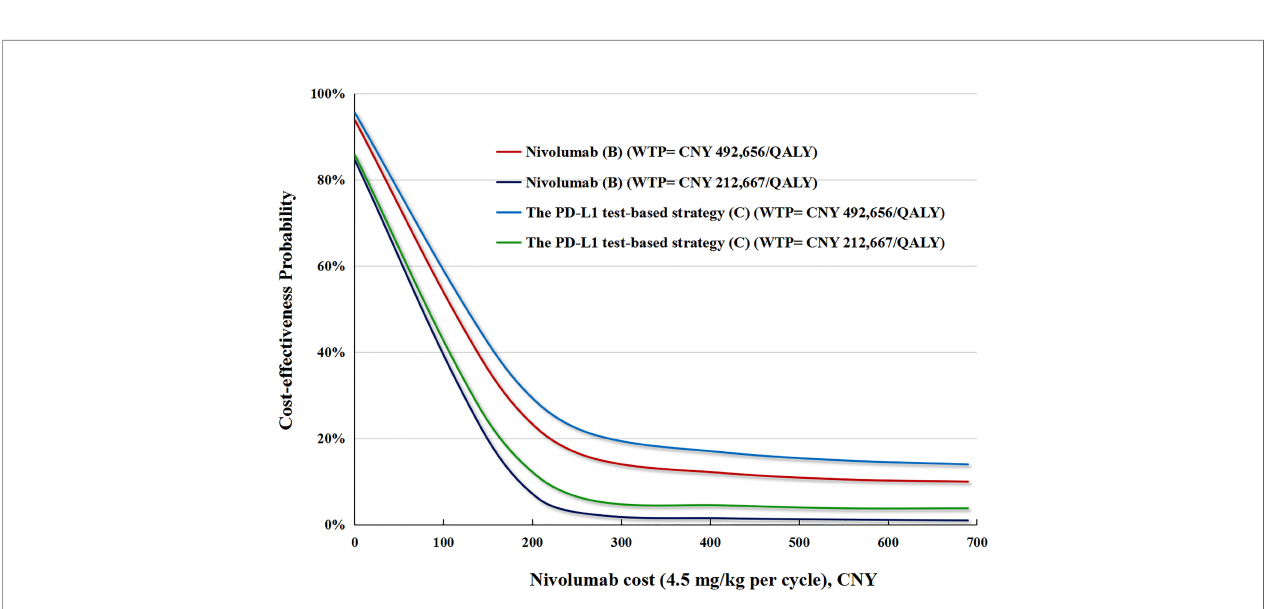
FIGURE 4 | (A) The cost-effectiveness probability achieved by the PD-L1 test-based strategy (C) and nivolumab (B) compared to docetaxel (A) at different WTP thresholds. QALY, quality adjusted life-year; WTP, willingness-to-pay; PD-L1, programmed death ligand.